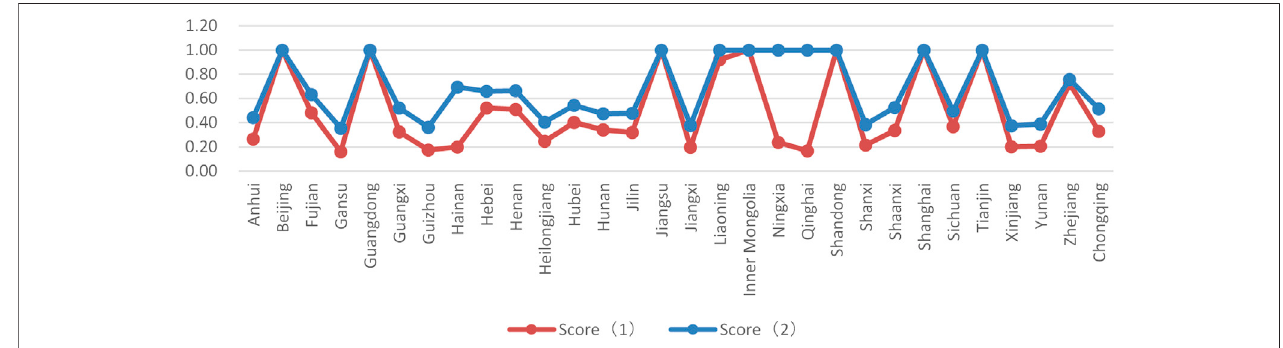
FIGURE 6 | Total ef fi ciency score before and after processing